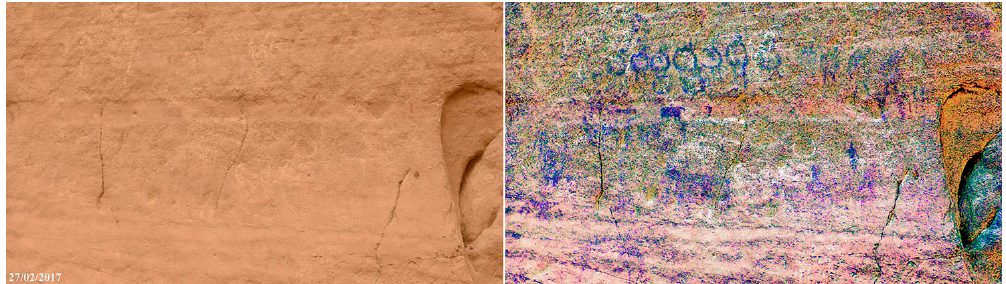
Figure 7. Faded paintings on the eastern sector of shelter wall, at P2 (Figure 4). The enhanced image to the right (DStretch YBK colour space) shows a line of warriors, partially hidden behind round shields (Photo: Mauro Colella).